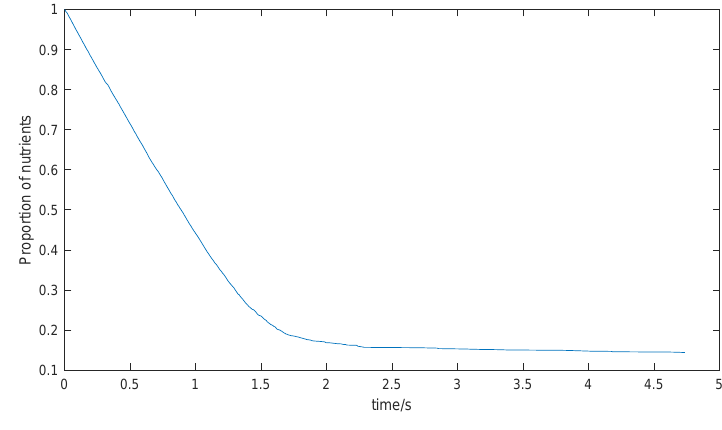
Figure 13. The decreases in the